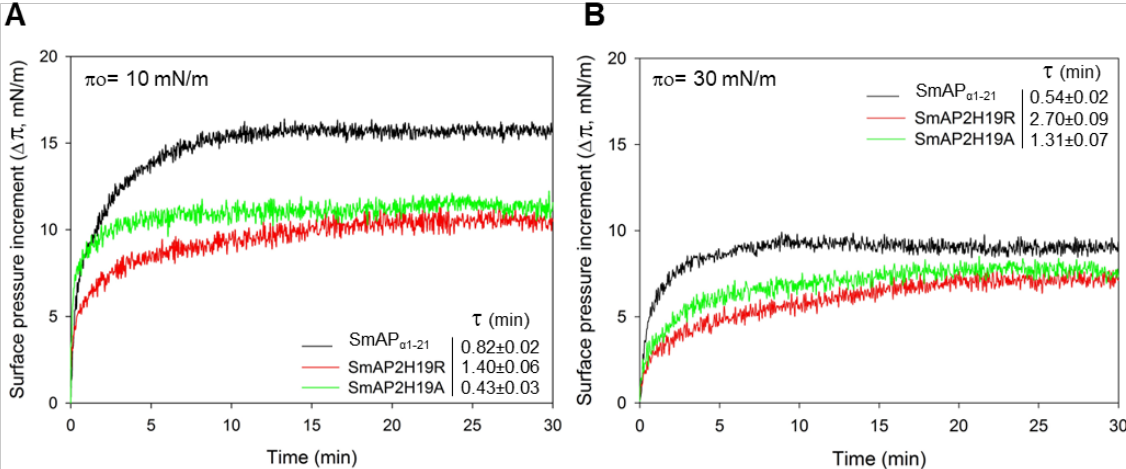
Figure 3. Peptide interaction with fungal-like lipid monolayers. Kinetics of insertion of SmAP α1 -21 (black trace), SmAP2H19R (red trace), and SmAP2H19A (green trace) into POPC – ergosterol (3:1 mole ratio) monolayers at initial surface pressures (π o ) of ( A ) 10 mN/m and ( B ) 30 mN/m. Peptides were injected beneath monolayers at the depicted π o to give final concentration of 20 µ M in subphase bulk, and the increase in surface pressure ( ∆ π ) was monitored over time. Time ( τ ) needed to achieve half of Δπ eq is presented for each peptide at both π o values and was obtained by fitting Δπ vs time curves to Eq. 1 ( cf. Material and Methods section). Measurements were performed at 23 ± 1 °C.